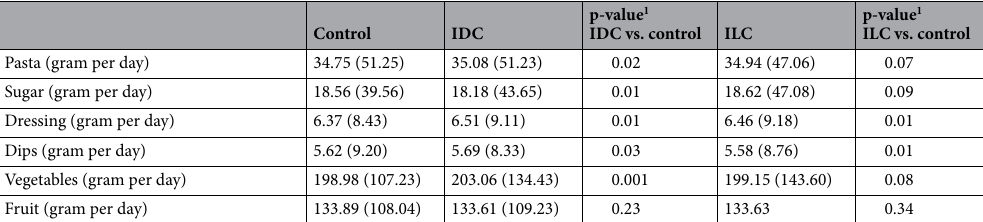
Table 1. General characteristics, dietary variables, and WD score between controls and IDC cases, and between controls and ILC cases. IDC invasive ductal carcinoma, ILC invasive lobular carcinoma, SD standard deviation, WDS Western diet score. 1 p-value are based on t-test (continuous variables) or X 2 (categorical variables). ^ Underweight and normal BMI were merged in one group (due to the small number of